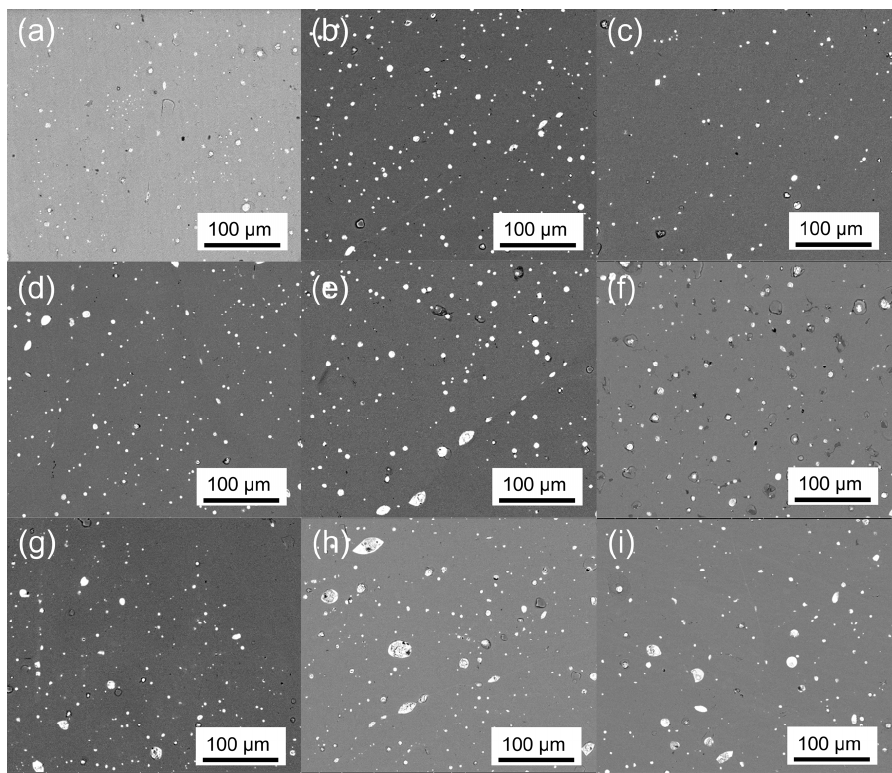
Figure 4. SEM BSE images of samples: ( a ) 0; ( b ) 1; ( c ) 2; ( d ) 3; ( e ) 4; ( f ) 5; ( g ) 6; ( h ) 7; ( i ) 8.